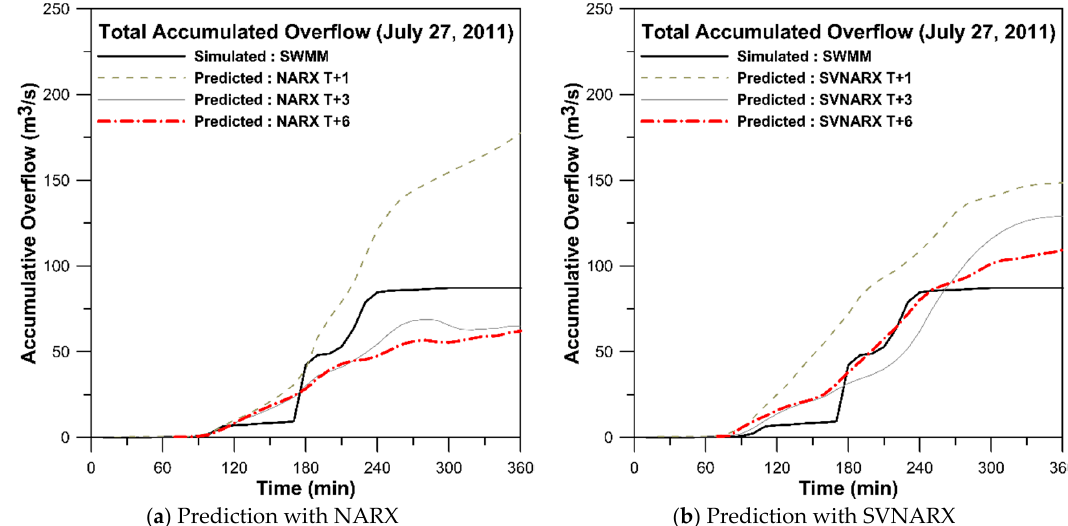
Figure 8. Total overflow prediction of NARX and SVNARX.